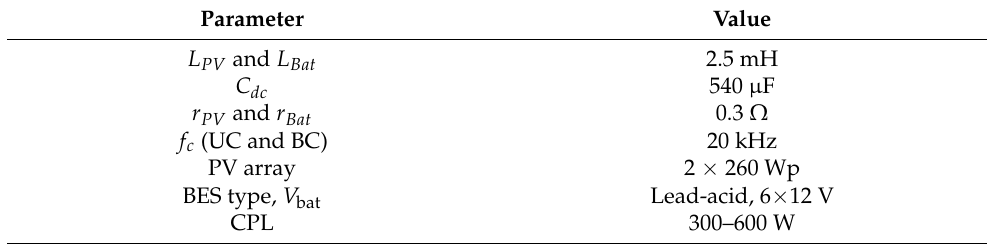
Table 1. System parameters.